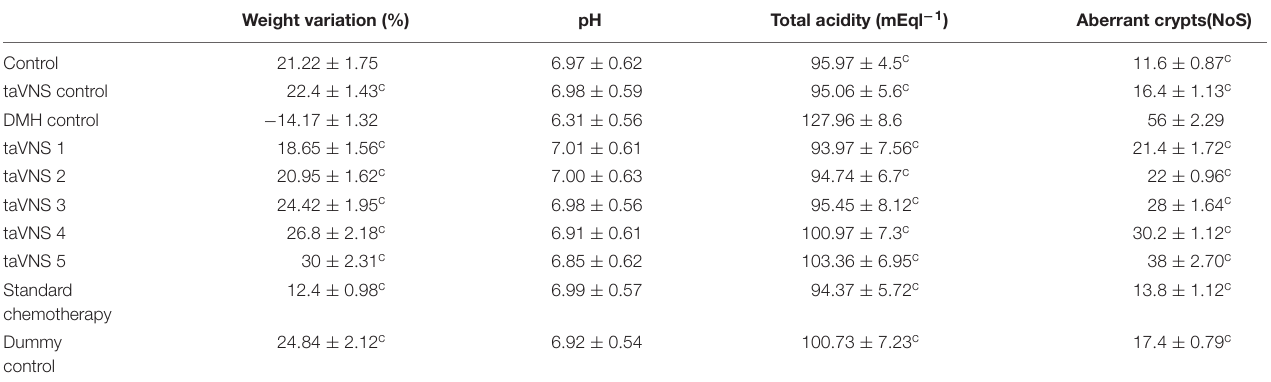
TABLE 1 | Effects of taVNS on weight variation, pH, total acidity, and ACF